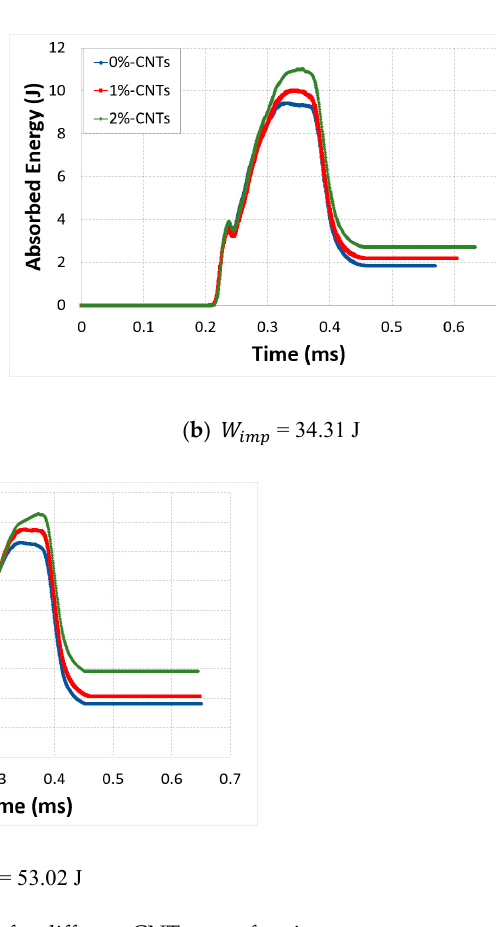
Figure 9. Absorbed energy vs. time for different CNTs mass fractions.